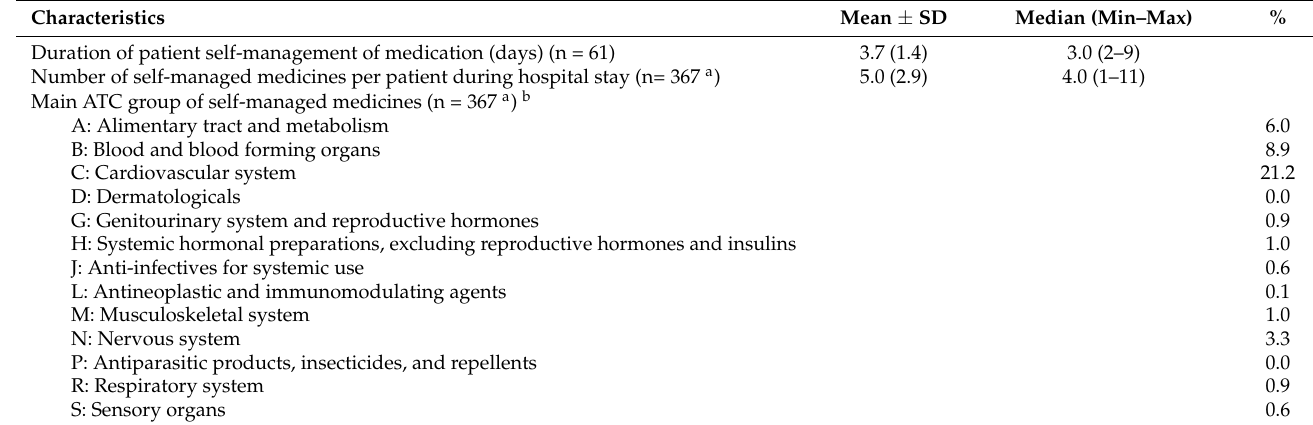
Table 3. Assessment of self-managed